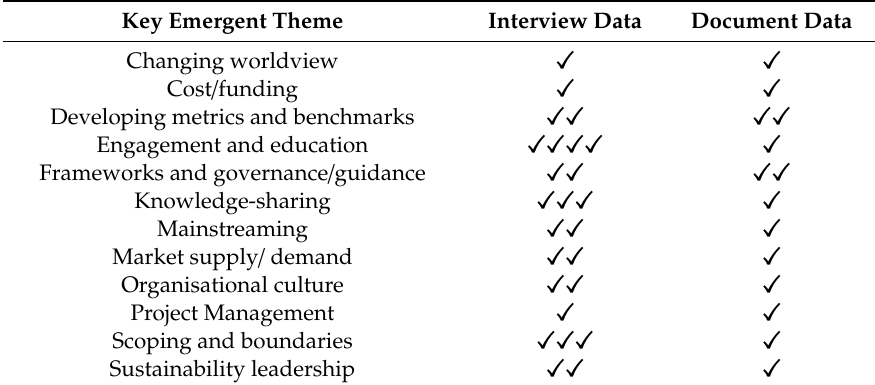
Table 3. Summary of emergent themes from case-study